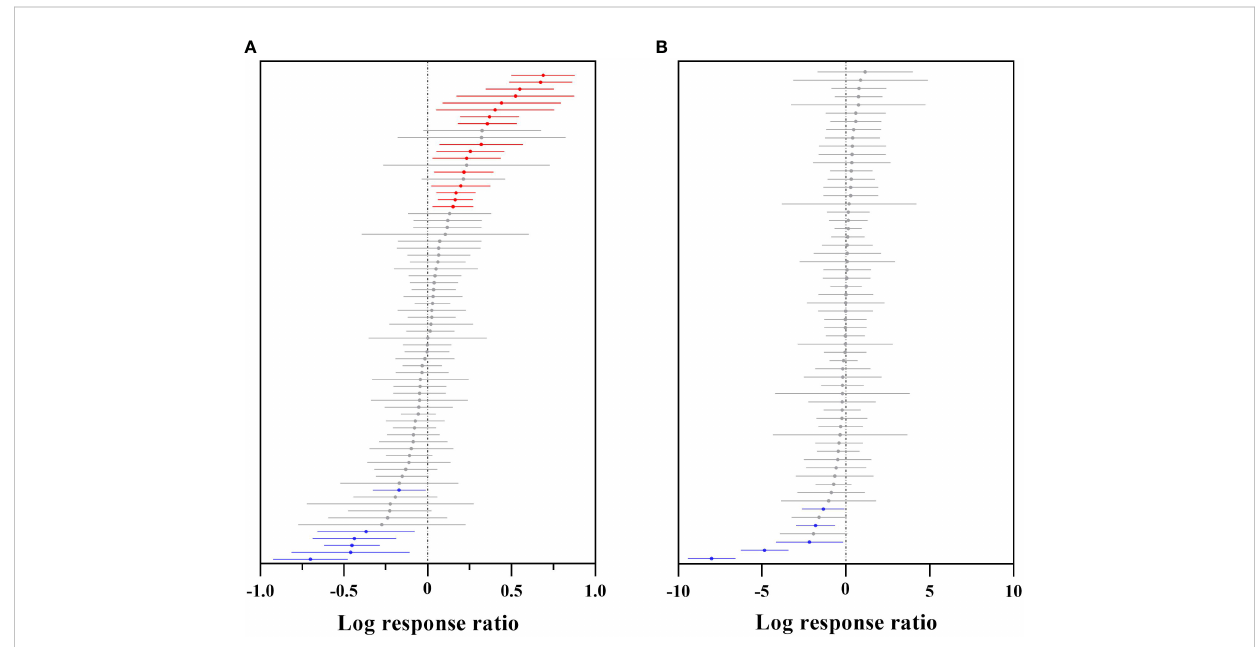
FIGURE 5 Effect sizes of different plant genera of Chinese woody plants. (A) indicates the overall suitable area, and (B) indicates the highly suitable area. The effects of future climate on the overall/highly suitable area (main effects) of different woody plant genera are indicated. Error lines indicate 95% con fi dence intervals. Signi fi cant positive effect (bright red color), signi fi cant negative effect (bright blue color), and nonsigni fi cant effect (grey color).